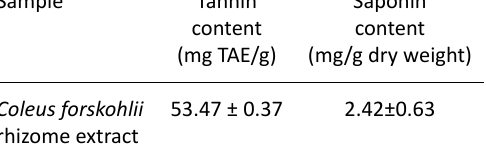
Table 2. Quantitative estimation of tannin and saponin content from rhizome extract